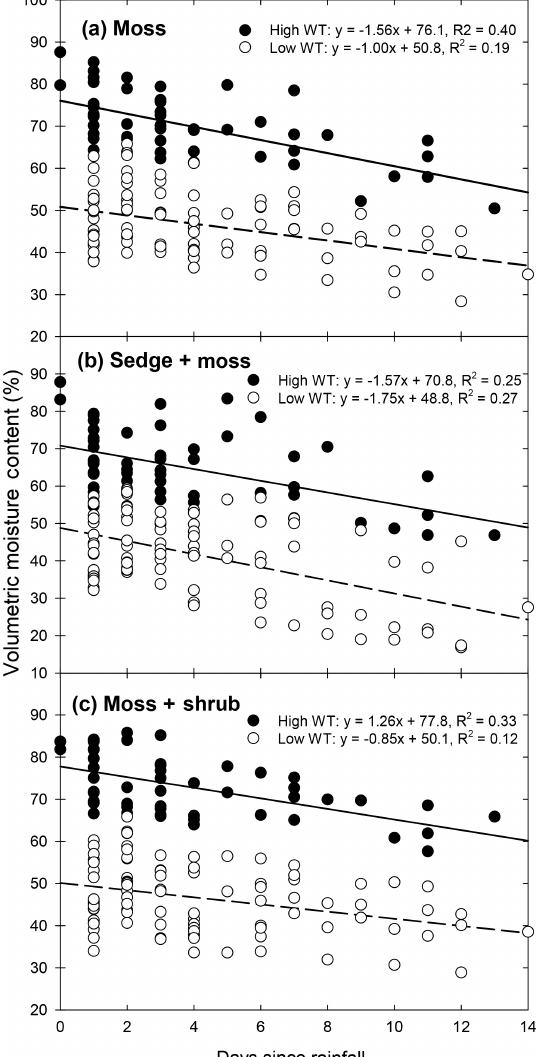
Figure 2. Relationship between daily average VMC and days since the last rainfall/irrigation event for (a) moss, (b) sedge + moss, and (c) moss + shrub monoliths. Data for each vegetation type are separated between high WT and low WT portions of the exper- iment. Data are combined between precipitation frequency treat- ments. Linear regressions are provided. All regressions were sig- nificant ( p < 0 . 05).